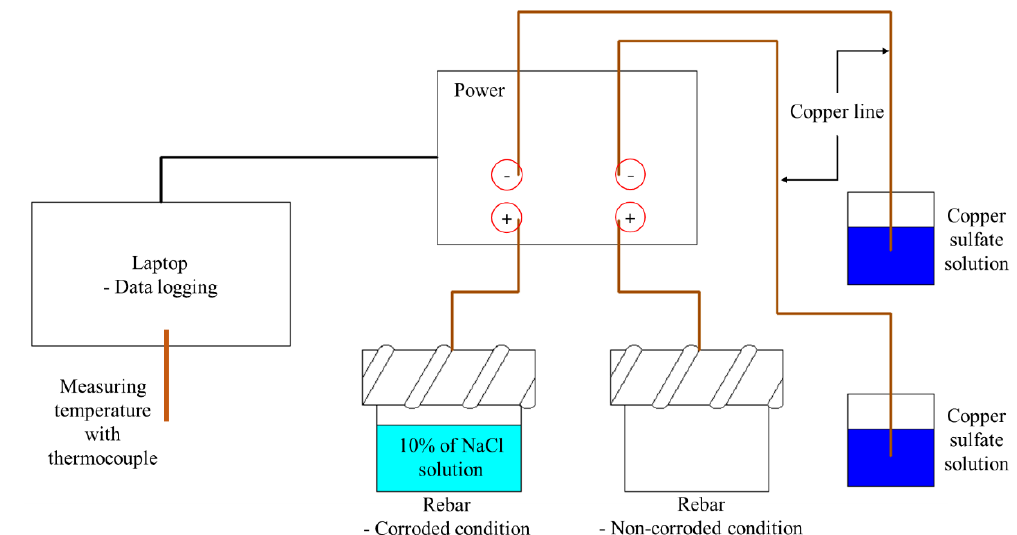
Figure 2. Experimental setting to measure corrosion potential.